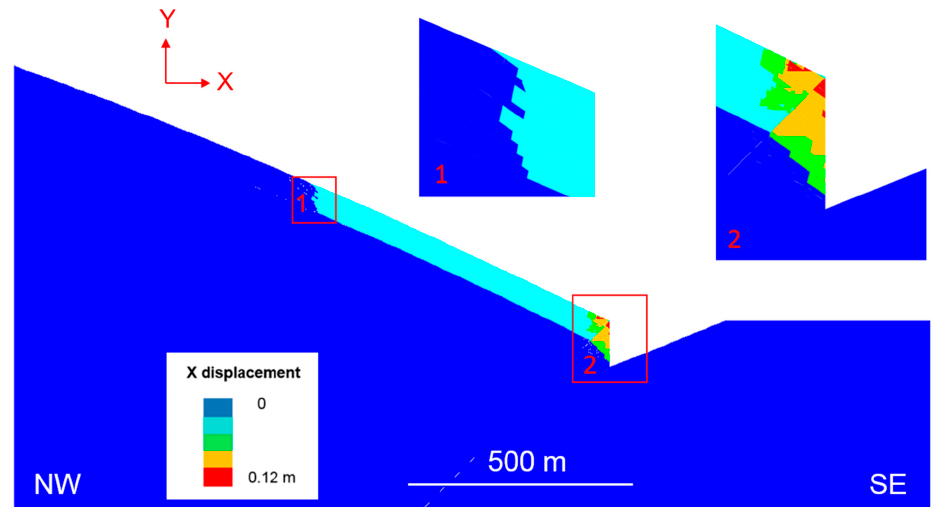
Figure 13. The result of numerical stability analysis showing the contour of X displacement with the close-up (1 and 2) of structurally defined landslide scarp and step-path slip surface at the toe of the slope in the modelling.